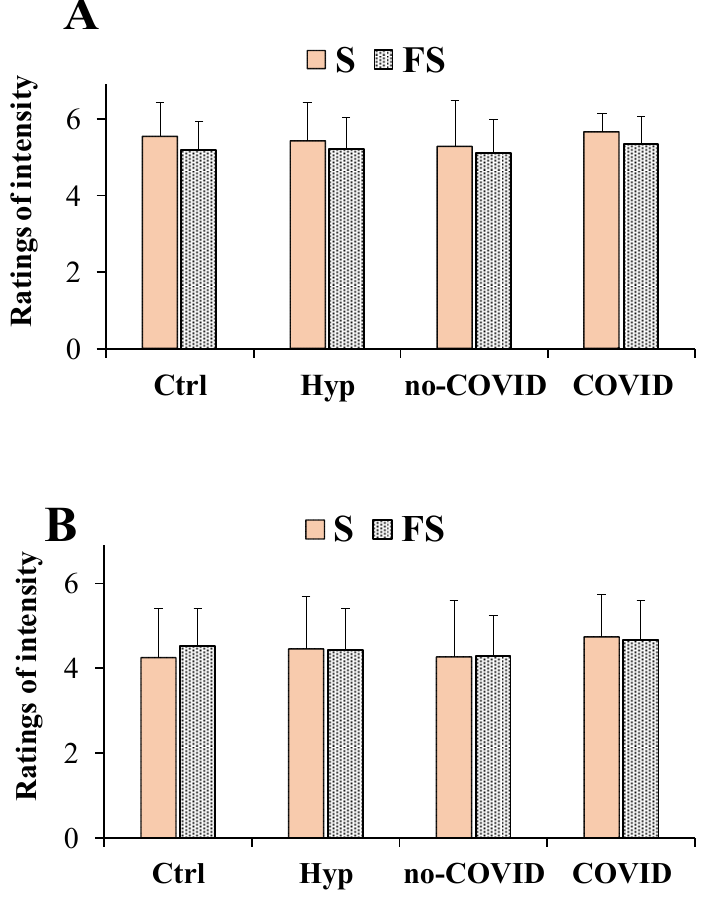
Figure 3. Ratings of intensity dimension in total patients with hyposmia (Hyp, n = 57), subjects without (no-COVID, n = 34) or with (COVID, n = 23) post-acute Coronavirus Syndrome compared to healthy controls (Ctrl, n = 91), in response to the saline solutions obtained with pure salt (S) and flavored salts (FS) at the concentrations of 0.1 g/mL (high dose) ( A ) and 0.04 g/mL (low dose) ( B ). Data are presented as mean values and standard deviations. Regarding FS, each value of the taste dimensions was obtained as the mean of participant responses to the three different commercial FS samples. Significant differences among the four different groups of subjects (as between factors) in relation to the type of salt (S and FS as within factor) were calculated using a two-way repeated measures ANOVA.